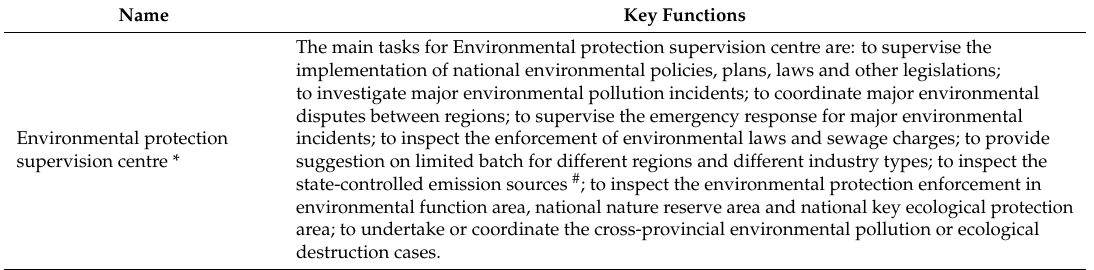
Table A5. The major regional collaboration mechanisms on air pollution control in BTH